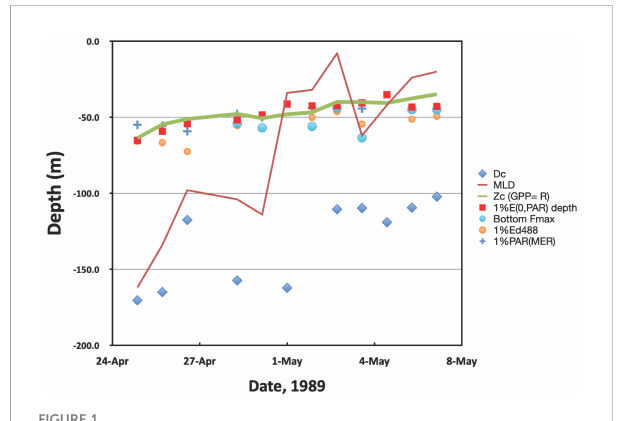
period. There are no appropriate 14 C assimilation data for 28 April. Also, there was no fl uorescence maximum for the fi rst three days of observations. Dc is a proxy for the critical depth (Eq. 8). Dc for 29 April and 2 May exceed -200 m (see Table 2) and are not plotted. MLD = mixed layer depth, Zc is the compensation depth. 1% Ed(488) and 1%PAR(MER) are data from the Biospherical Marine Environmental Recorder